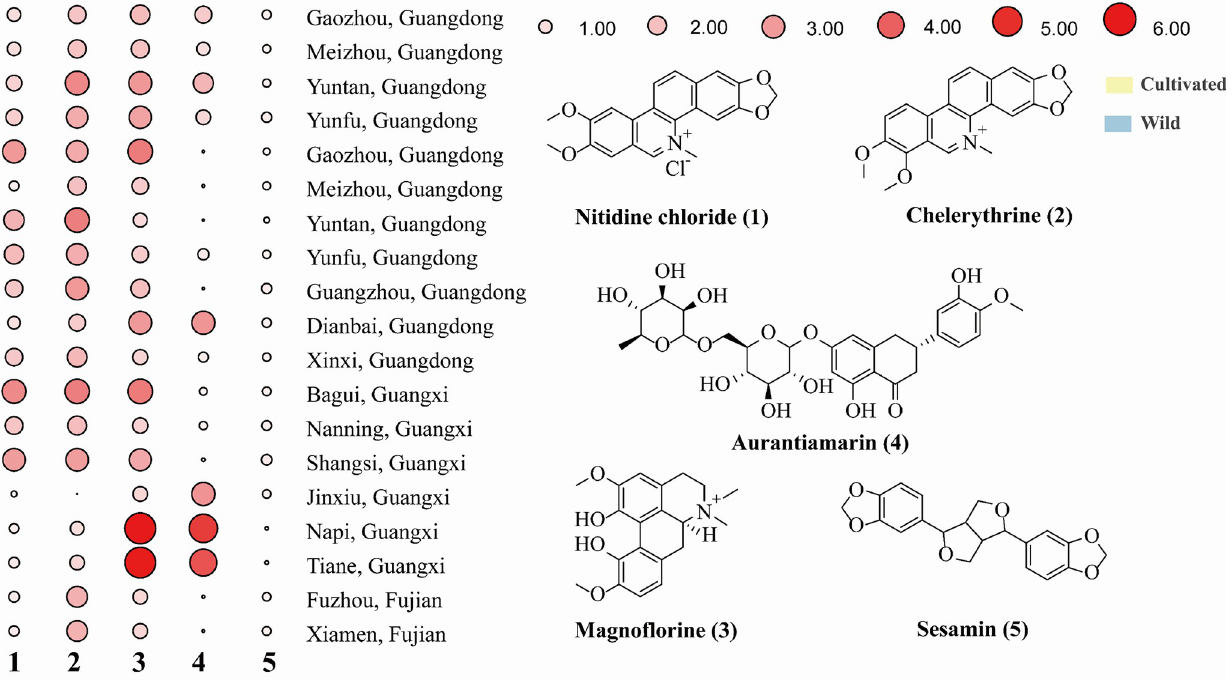
Fig 2. Heat map showing the contents of five active components in Z . nitidum from different regions.